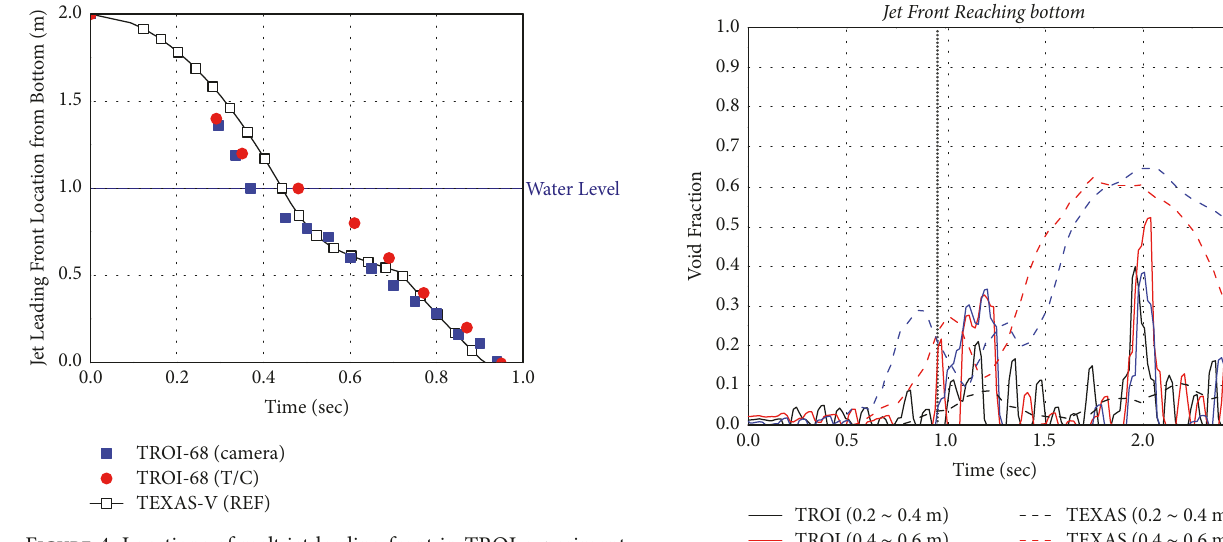
Figure 4: Locations of melt jet leading front in TROI experiment and TEXAS-V simulation for the partially flooded cavity condition.